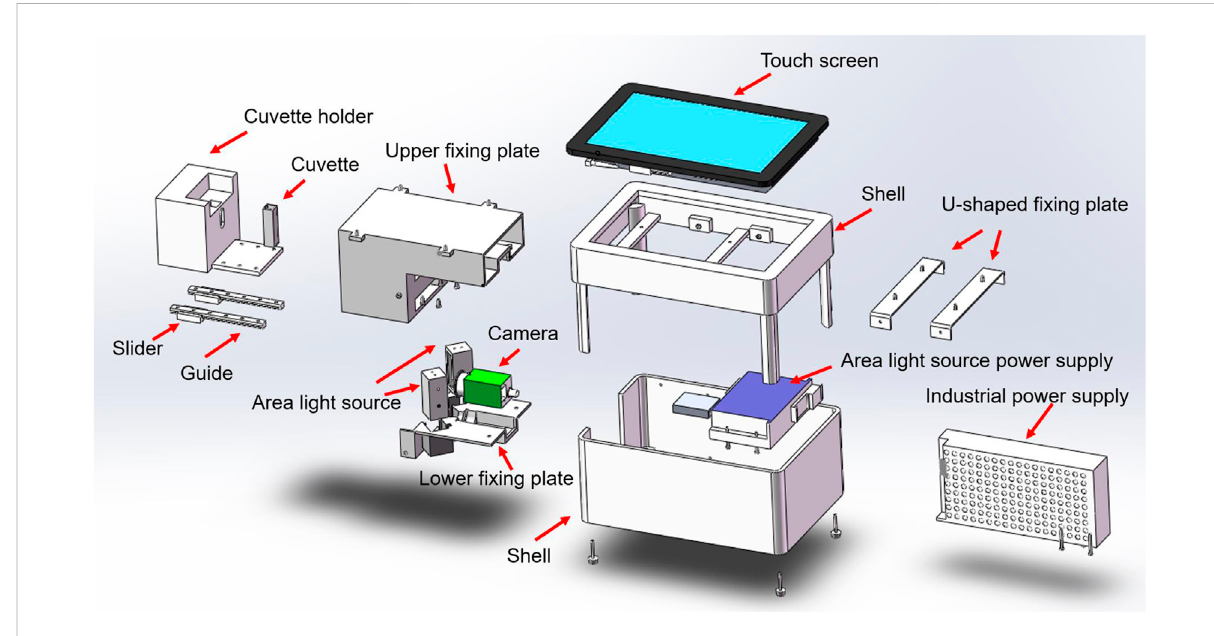
FIGURE 2 Schematic of the system hardware